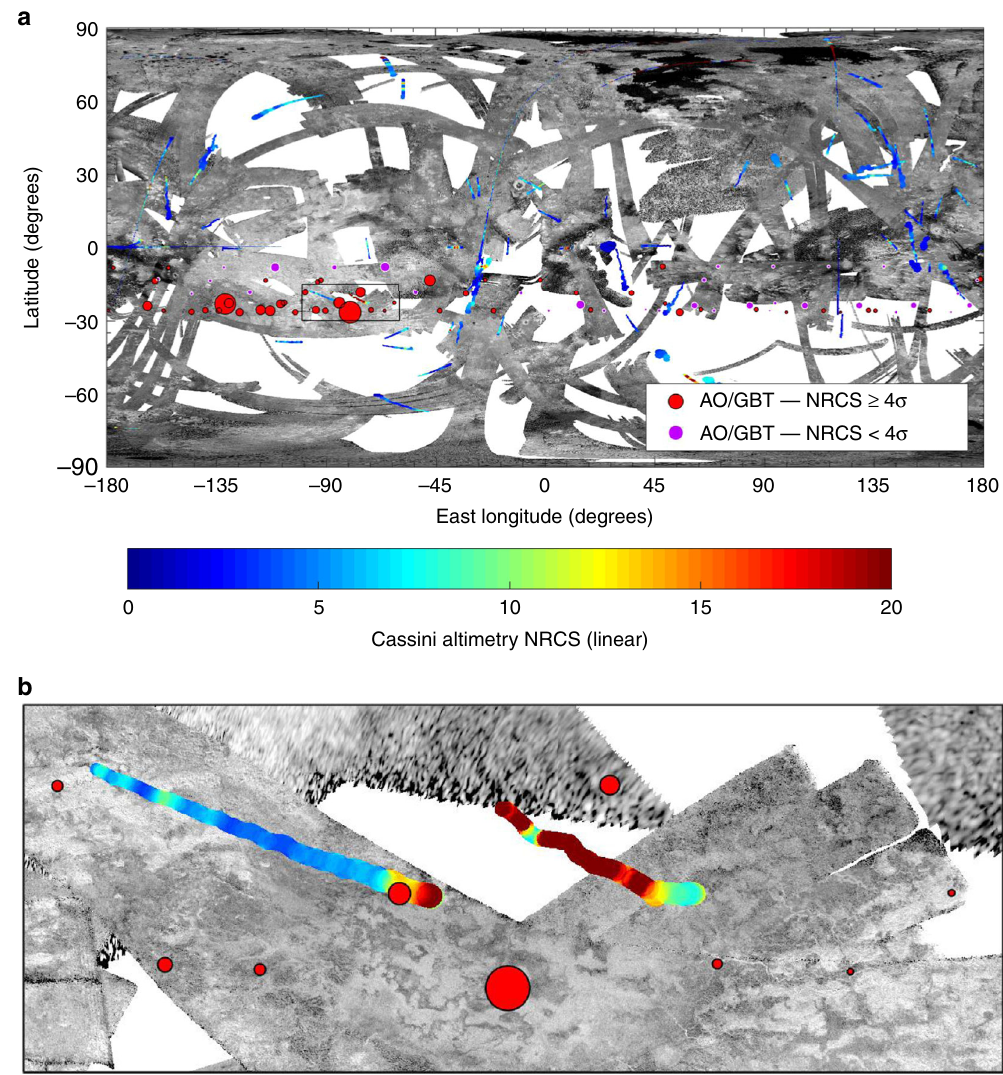
Fig. 2 Map of Titan. a The monochrome swaths are Cassini RADAR 11 images. The purple and red dots are AO/GBT subradar locations; red dots are locations where the maximum-NRCS was ≥ 4 standard deviations above the noise. Dot radii are linearly proportional to maximum-NRCS. Colored tracks are Cassini RADAR altimetry observations where color indicates NRCS. There is a high concentration of large, red dots at ≈ 70 – 135°W, 15 – 30°S and many Cassini altimetry observations in this region also have a high NRCS. b Boxed area enlarged. The colorbar applies to both a and b